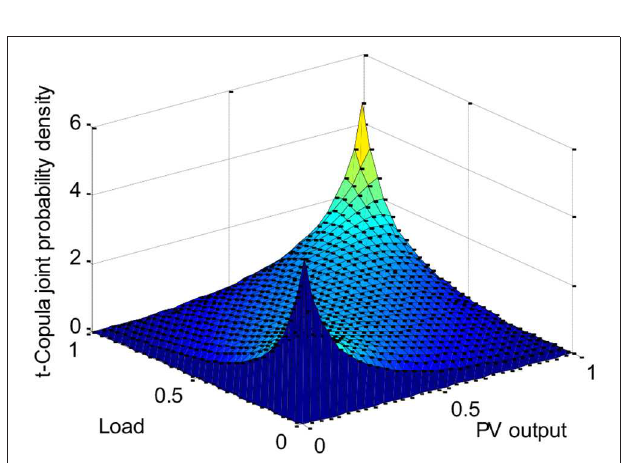
FIGURE 3 | Joint probability density of t-Copula.